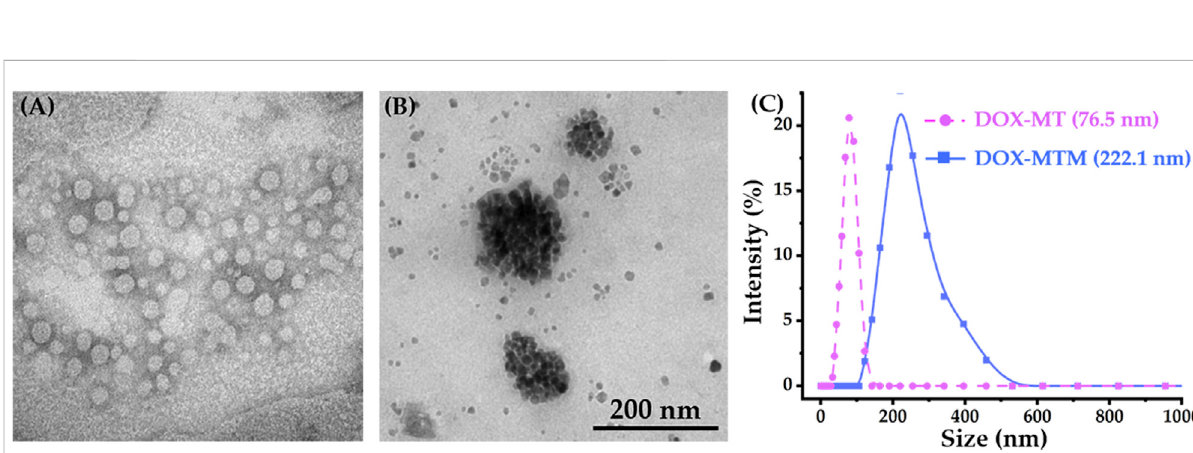
FIGURE 4 Morphologies (TEM) and particle size distributions (DLS) of DOX – MT and DOX – MTM: TEM result of (A) DOX – MTs and (B) DOX – MTMs; (C) DLS results of DOX – MT and DOX –